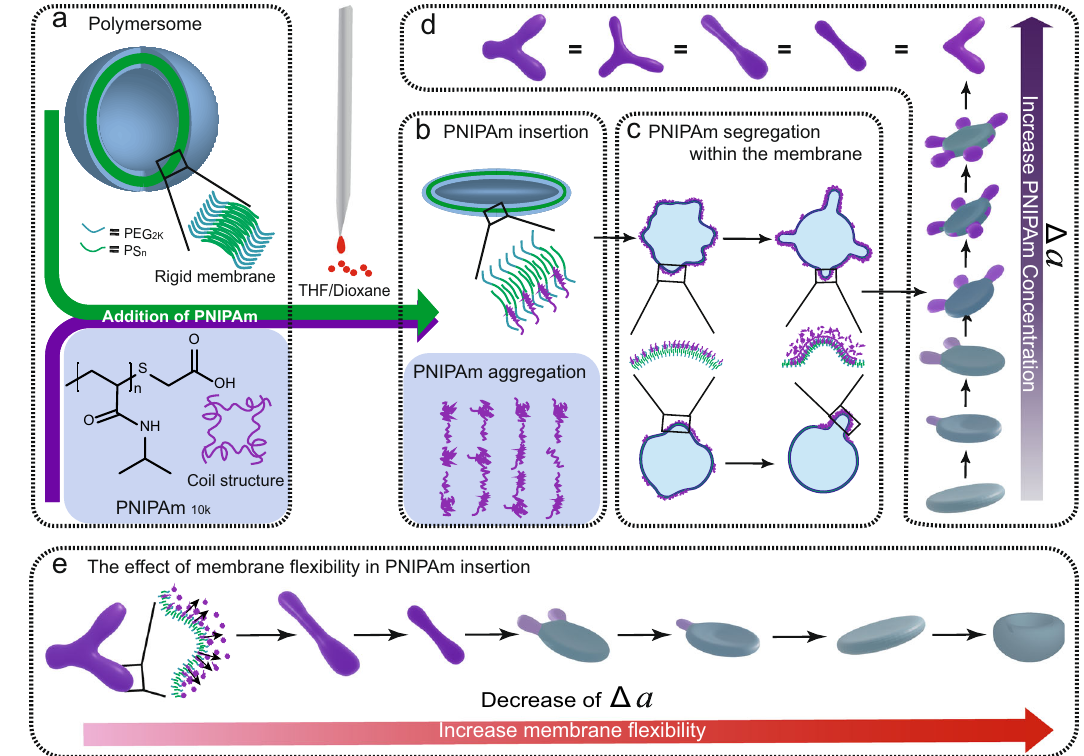
Fig. 1 Overview of the curvature formation in polymersome model. a Scheme of poly(ethylene glycol)-polystyrene (PEG- b -PS) polymersome, the membrane and PNIPAm structure. b Schematic representation of PNIPAm-membrane interaction after increasing the membrane fl exibility through plasticizing solvent addition (23.08% v/v). The addition of solvent leads to PNIPAm insertion into polymersomes membrane due to the shift from hydrophilicity to hydrophobicity. c Scheme of PNIPAm rearrangement in the polymersome membrane in different PNIPAm concentrations. d By increasing the PNIPAm concentration 3D structures of different shapes were obtained, including polymersomes with tentacles, cigar-like shapes, rackets-like shapes, boomerang-like shapes and 3-armed star fi sh-like shapes, “ = ” means they can appear simultaneously, purple color indicates the local distribution of PNIPAm. e Effect of the membrane fl exibility on the insertion of PNIPAm. A higher membrane fl exibility results in a lower percentage of insertion which is re fl ected in a decrease of the Δ a (reduced monolayer area